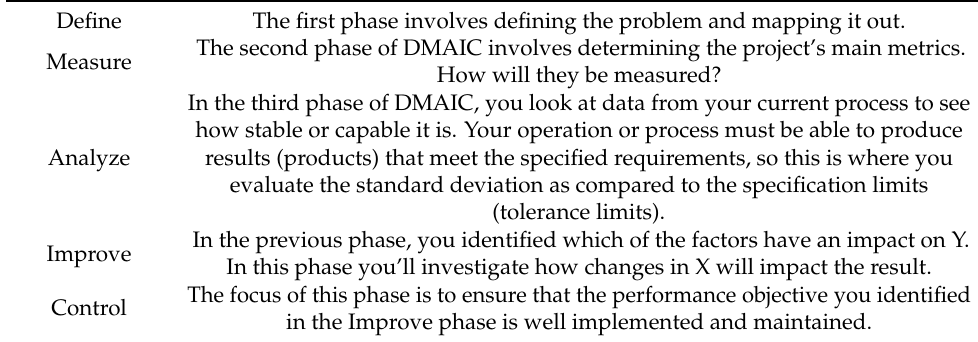
Table 2. Five stages of the